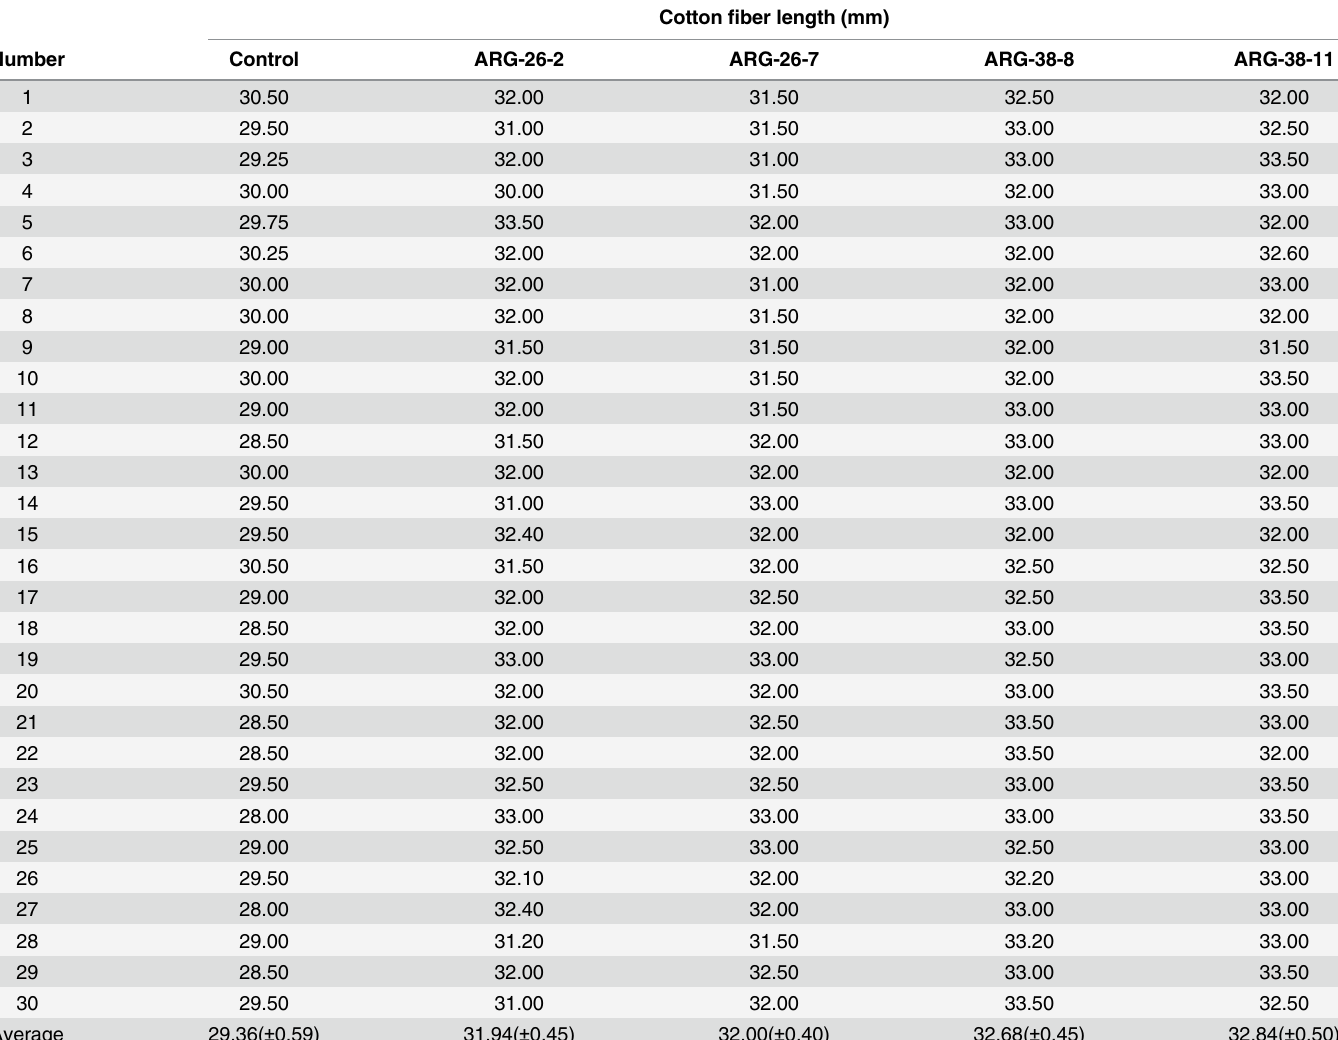
Table 2. Fiber length analysis in transgenic cotton and control